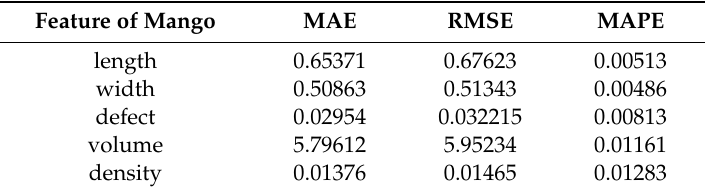
Table 2. The accuracy of estimated features.